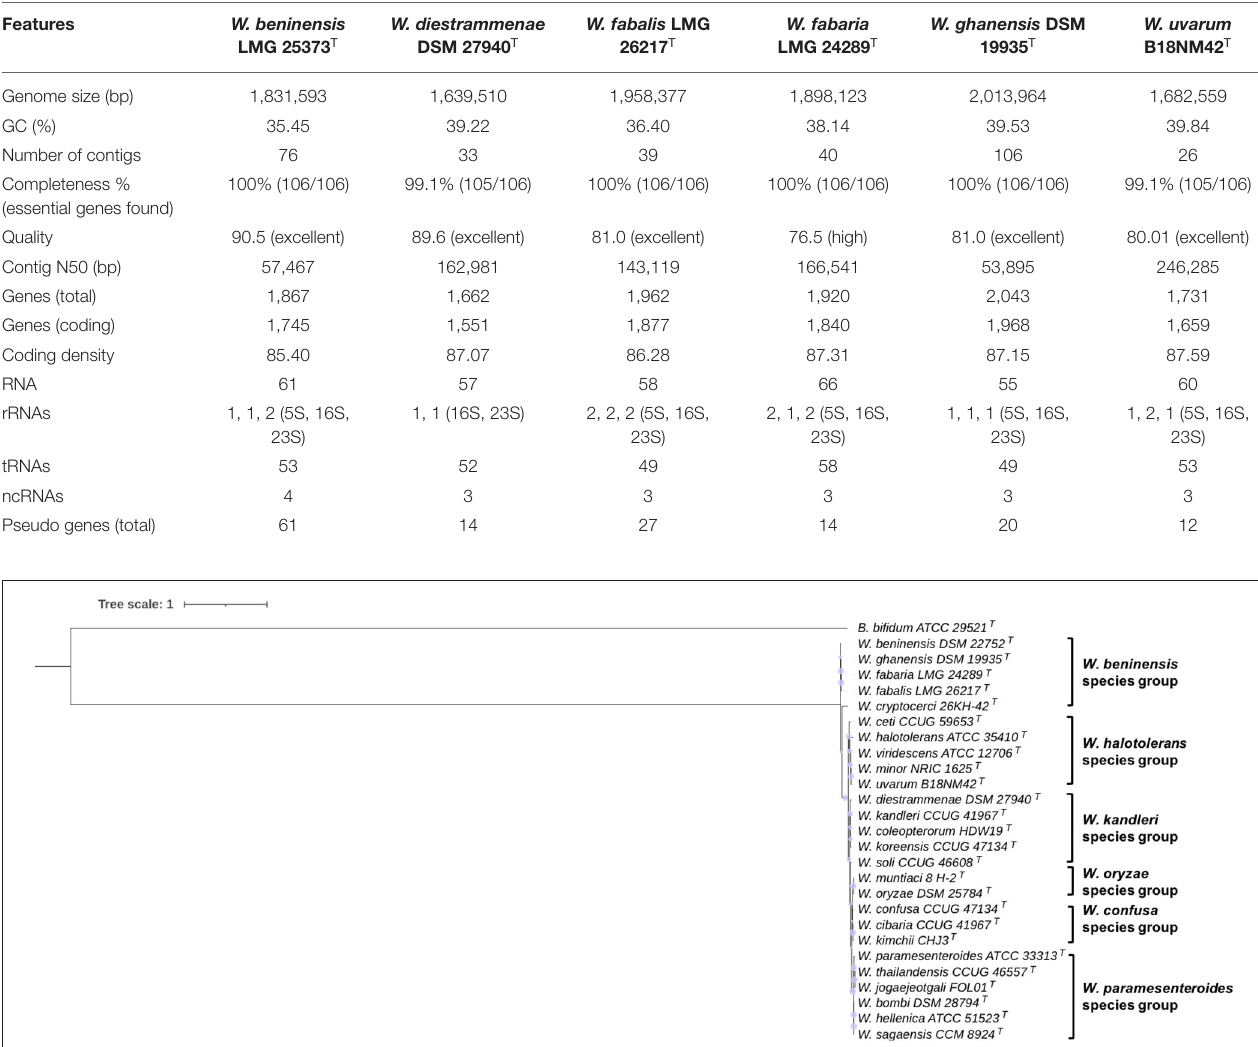
TABLE 1 | Genomic features of Weissella spp. strains.